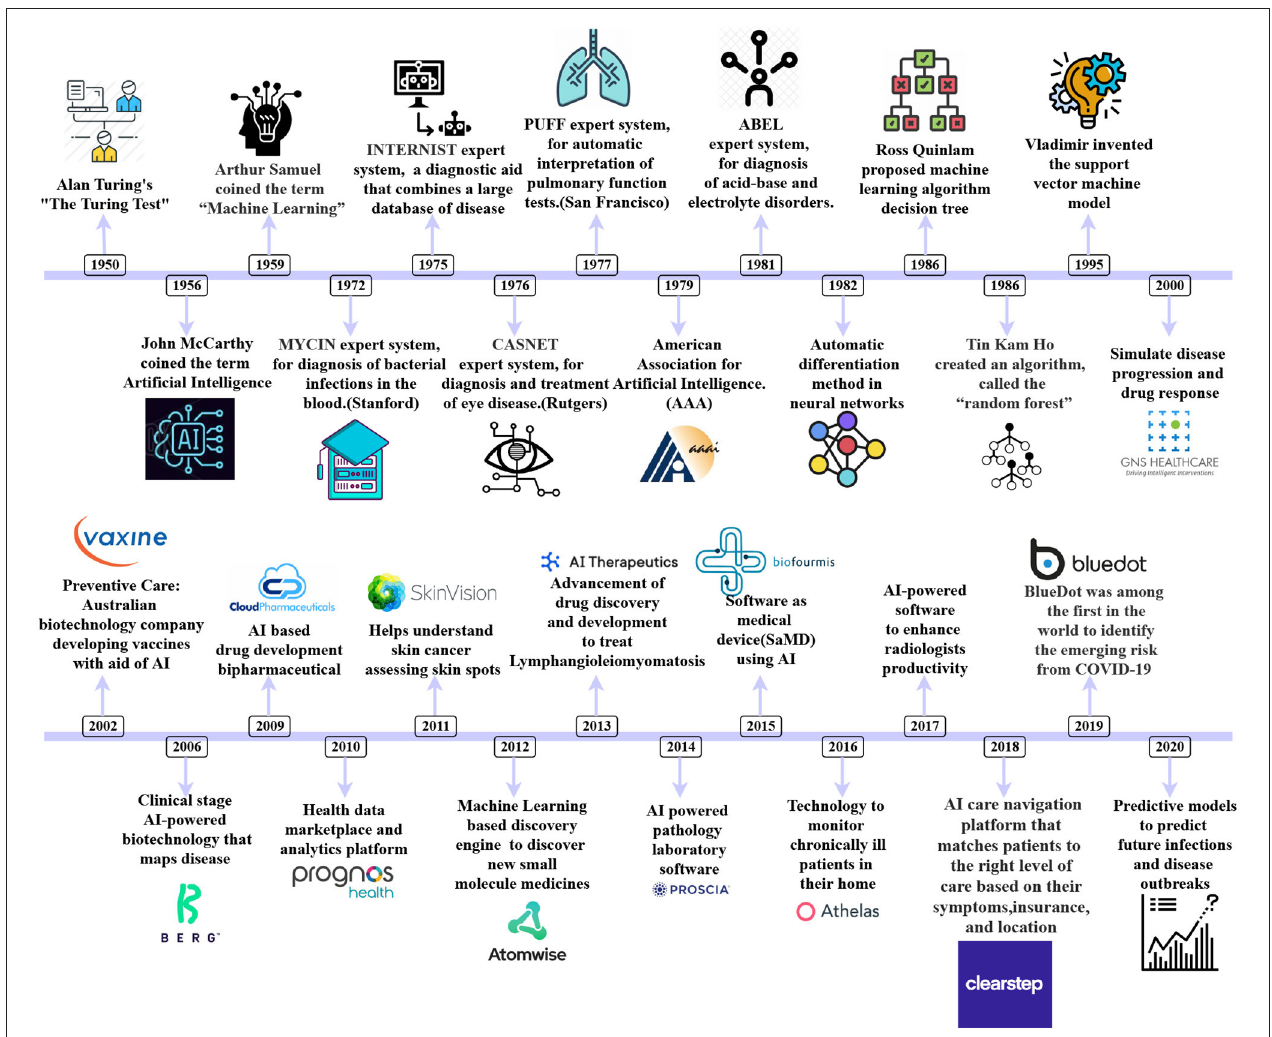
FIGURE 1 | A chronological representation of Artificial Intelligence in Healthcare from 1952 to